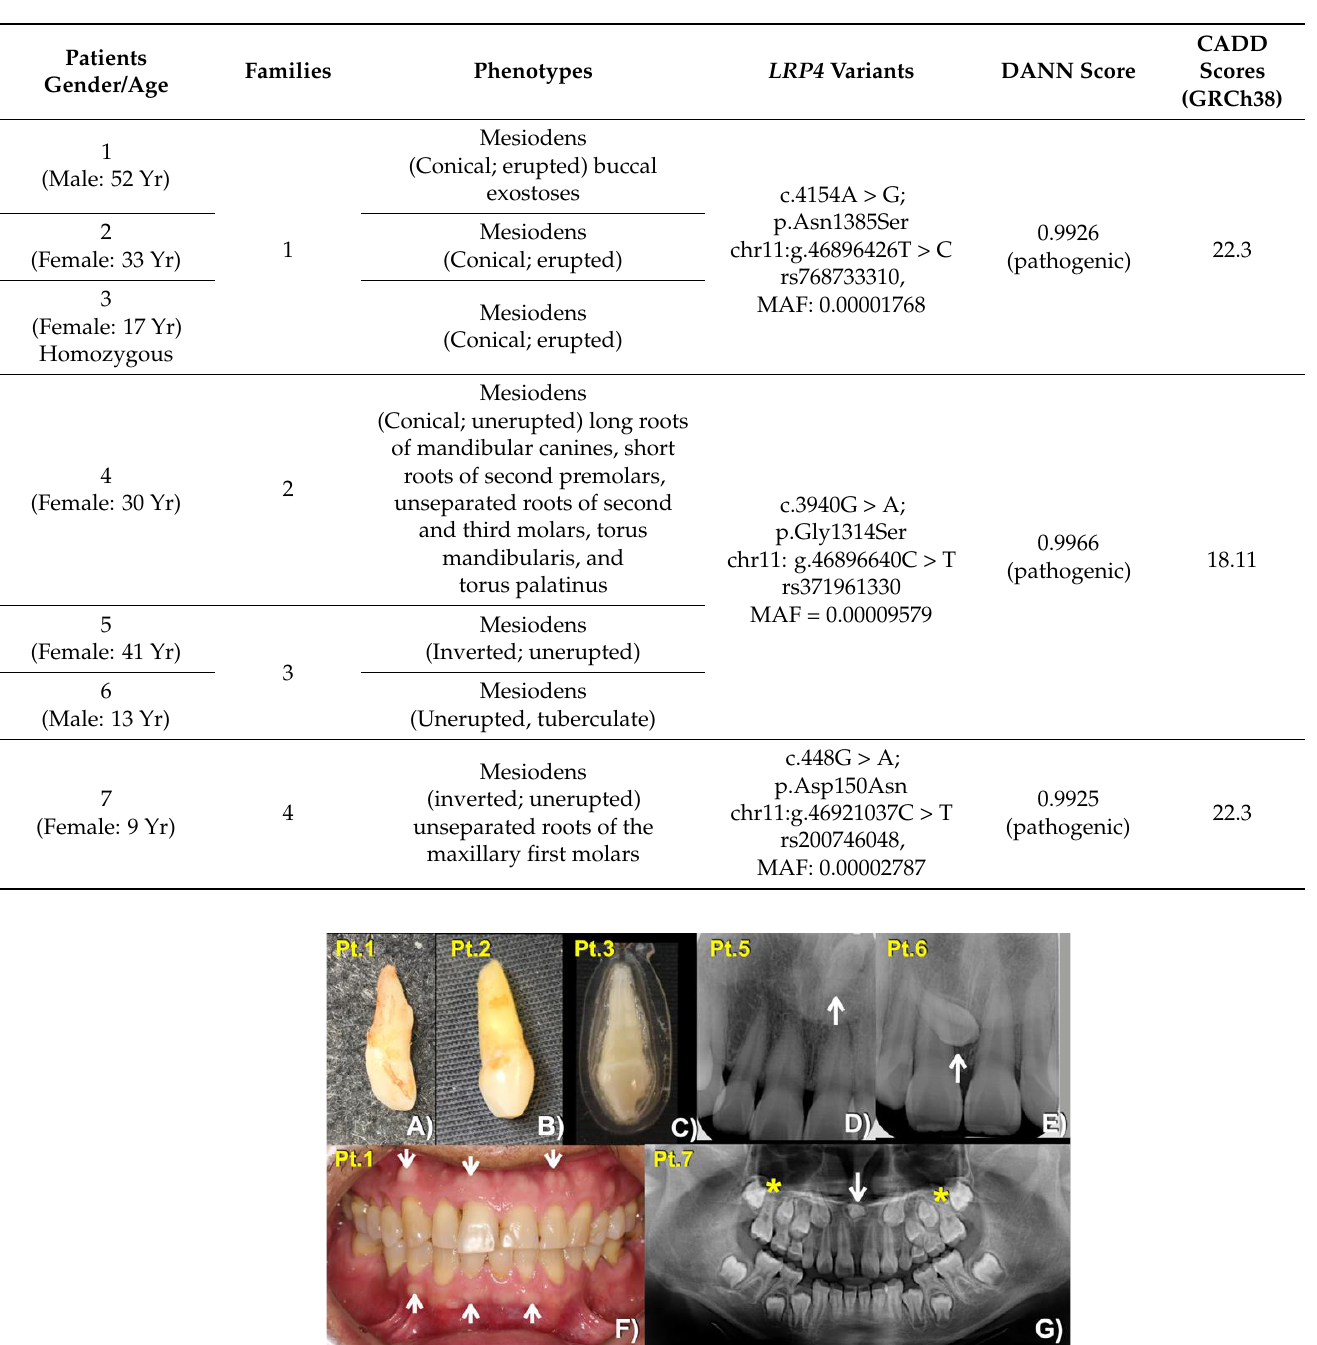
Figure 3. Patient 4. ( A ) Torus palatinus (arrow). ( B ) Torus mandibularis (arrows). ( C ) Panoramic radiograph showing long roots of mandibular permanent canines, short roots of second premolars, and unseparated roots of second and third permanent molars (arrows).